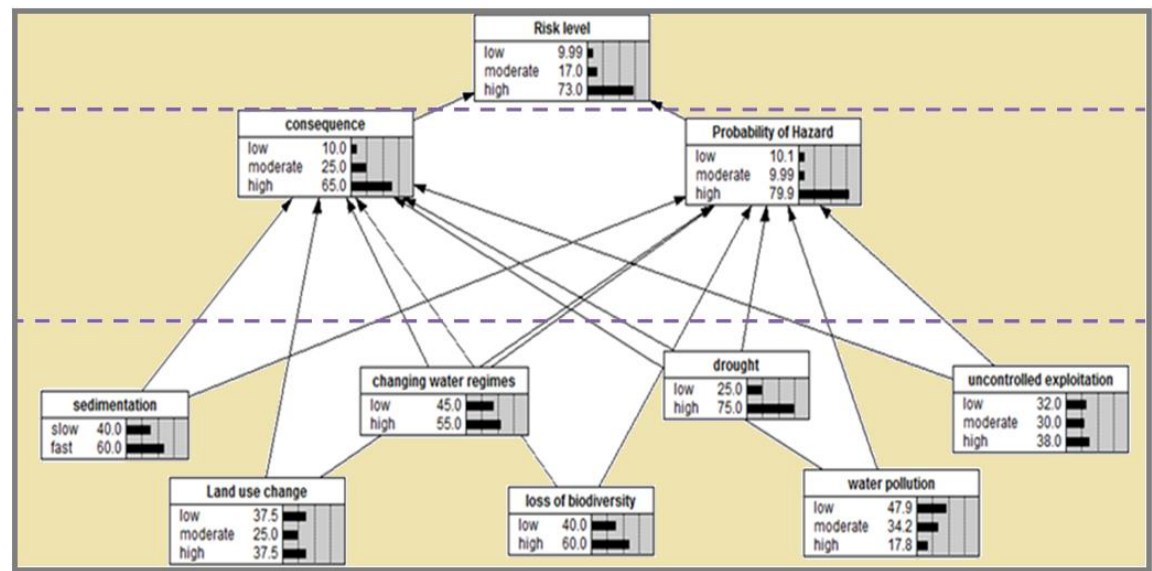
Figure 6. The BBN estimation of the levels of environmental risks for SIWs.